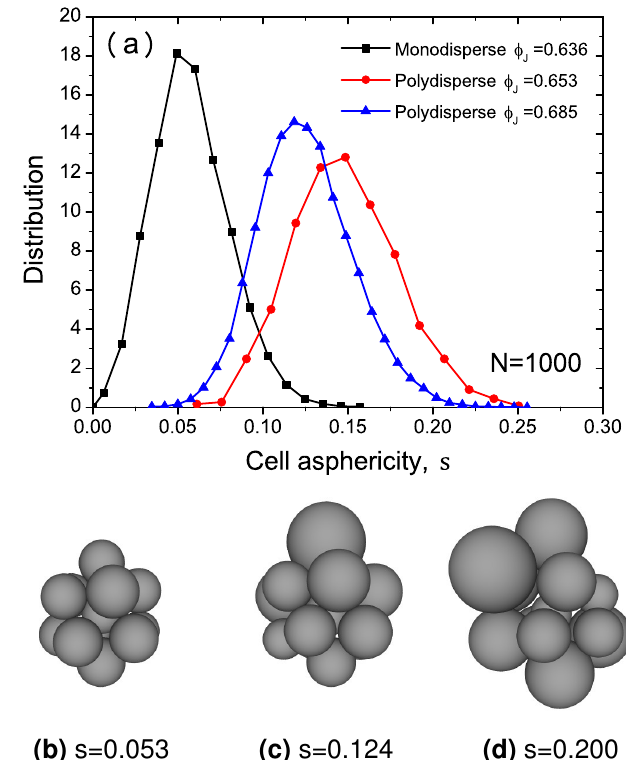
Figure 5: (a): Distribution of asphericity parameter s for polydisperse hard spheres for two different volume fractions, and for a monodisperse hard sphere system. (b, c, d): Typical icosahedral structures with varying degree of asphericity s